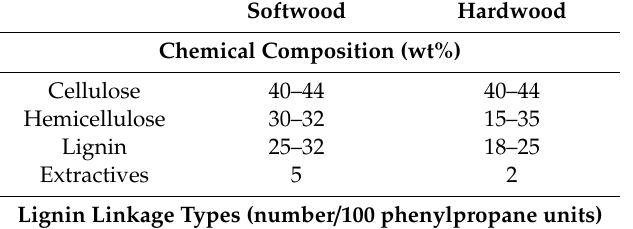
Table 1. General compositions of softwoods and hardwoods and their lignin linkages [27,28].